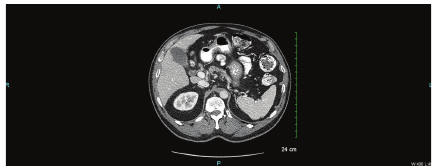
Figure3:AbdominalandpelvicCTscanshowingnormalsizedliver and